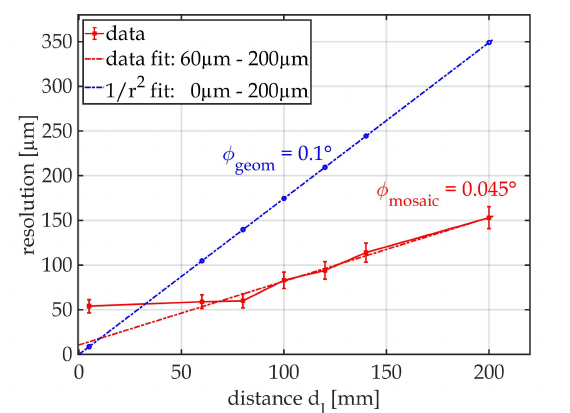
Figure 10. Spatial resolution as a function of distance of the edge from detector l d . Note the difference between the measured and calculated resolution, the latter using the 1/r 2 law and when the source geometry is assumed to be a pinhole rather than a mosaic crystal. φ geom = 0.1 ◦ means the geometric collimation obtained with a solid-state collimator and φ mosaic = 0.045 ◦ the measured beam collimation due to the mosaic crystal monochromator, see also